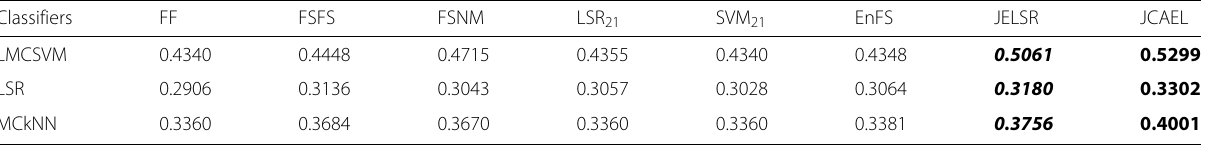
Table 5 Comparisons of feature selection algorithms on UCF10 ← AID in terms of average accuracy using three classifiers when the ratio of labeled video data are set to 5%